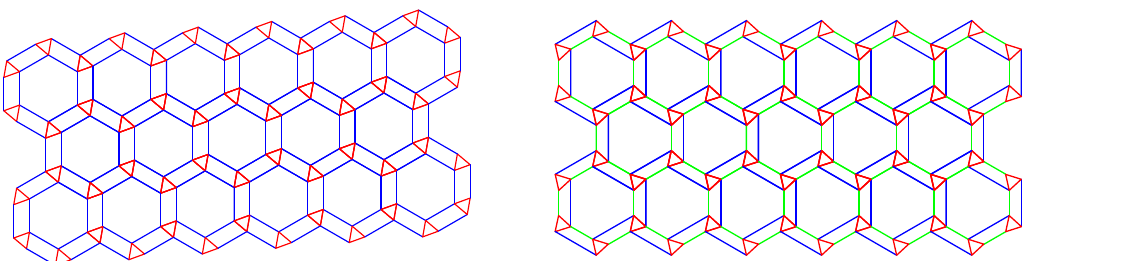
Fig. 26: Tiling with regular triangle, regular hexagon and two parallelograms (D).